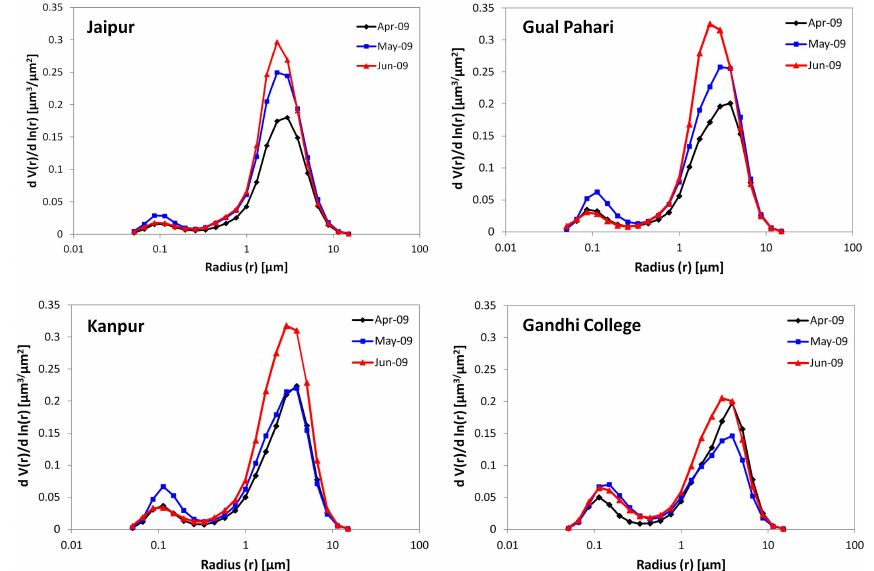
Fig. 7. Monthly mean aerosol size distribution from CIMEL sunphotometer over Jaipur, Gual Pahari (outskirts of Delhi), Kanpur and Gandhi College are shown for April (black), May (blue) and June (red)